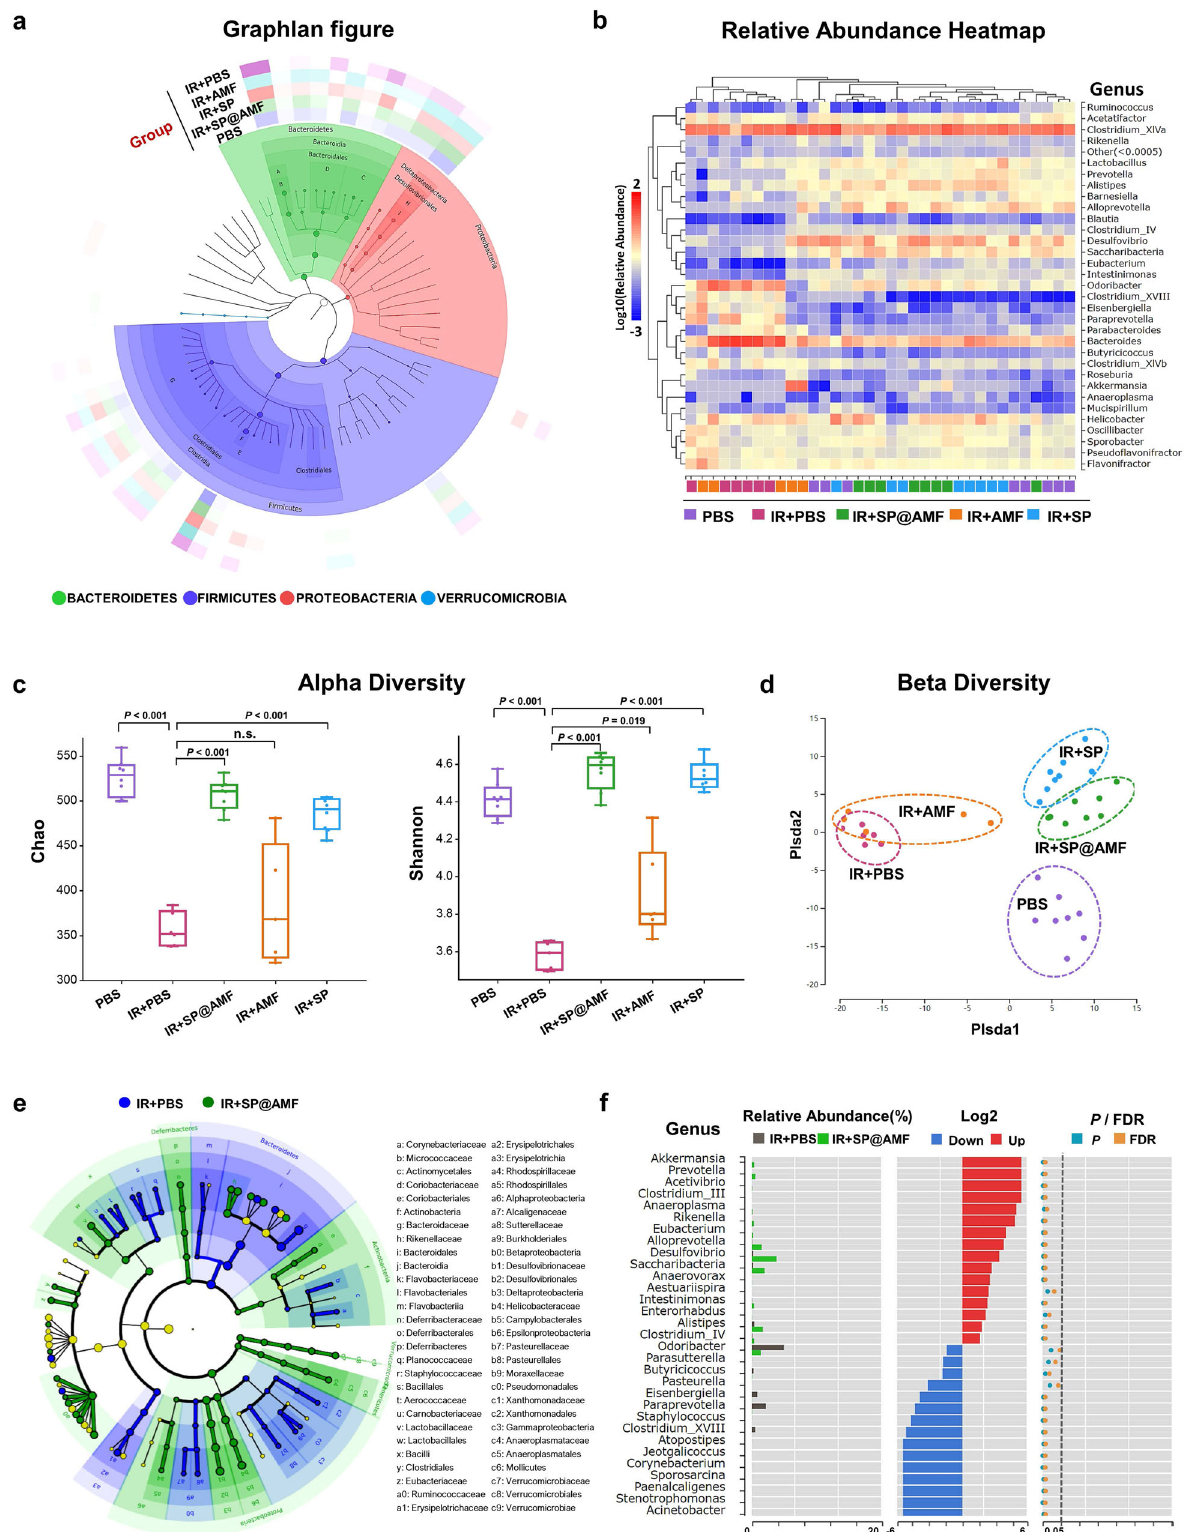
tissues was fi xed in 10% formalin for 24h and processed for HE and immunohistochemistry (IHC) assays to investigate the expression of Ki67 and γ H2AX. To avoid bias, the pathological sections were assessed by investigators who were blinded to the experimental treatments. The number of Ki67 staining regenerating crypts and γ H2AX + cells along the surrounding tissues of the intestinal cross-section were microscopically scored, and the length of